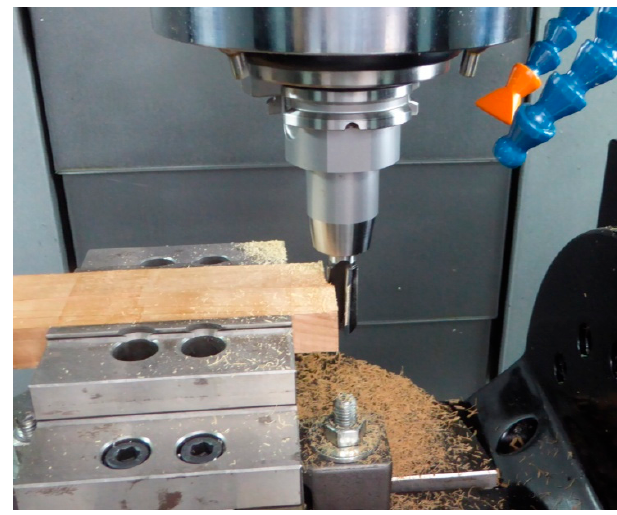
Figure 4. Machine tool AX320 Pinnacle with equipment for machining tests.